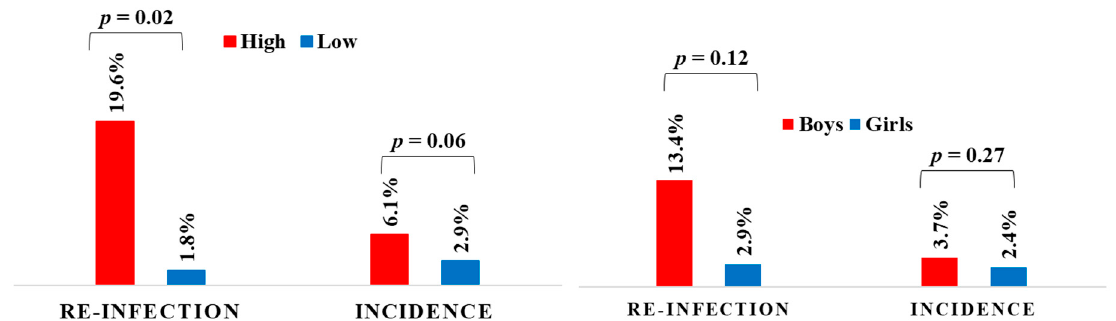
Figure 3. Reinfection rate and incidence in high- and low-infection areas ( left ) and among boys and girls ( right ) .